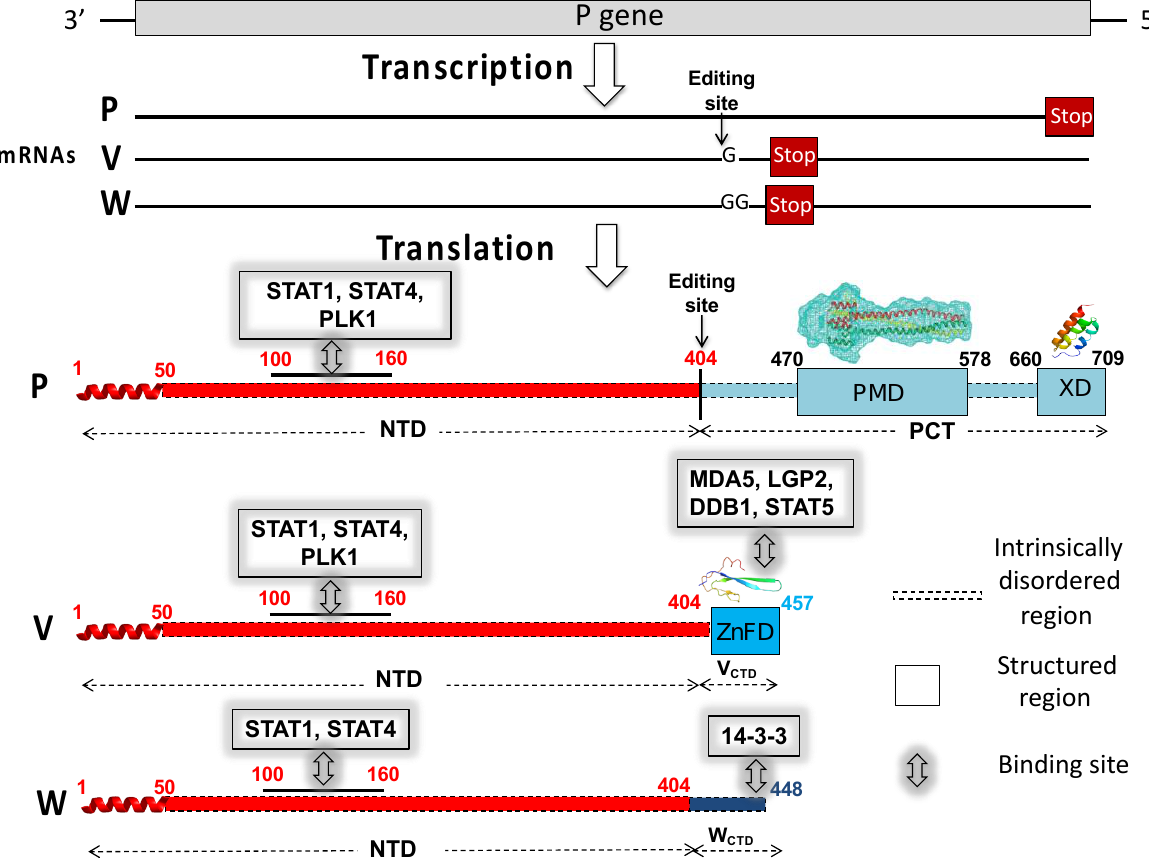
Figure 1. Coding capacity of the P gene and modular organization of the HeV P, V, and W proteins. Abbreviations: NTD, N-terminal region of P, V, and W; PCT, C-terminal region of P; PMD, P multimerization domain; XD, X domain of P; ZnFD, zinc finger domain; and V CTD and W CTD , C-terminal domain of V and W. The α -helix at the N-terminus of P, V, and W corresponds to the region shown to adopt a stable α -helical conformation upon binding of P to N [9] or upon binding of V to host cellular transporters [33]. The crystal structure of HeV XD (PDB code 4HEO) [15] and a model of HeV PMD [13] are shown. The W CTD is represented as disordered according to predictions [21]. Known interaction sites with human cell partners are shown.